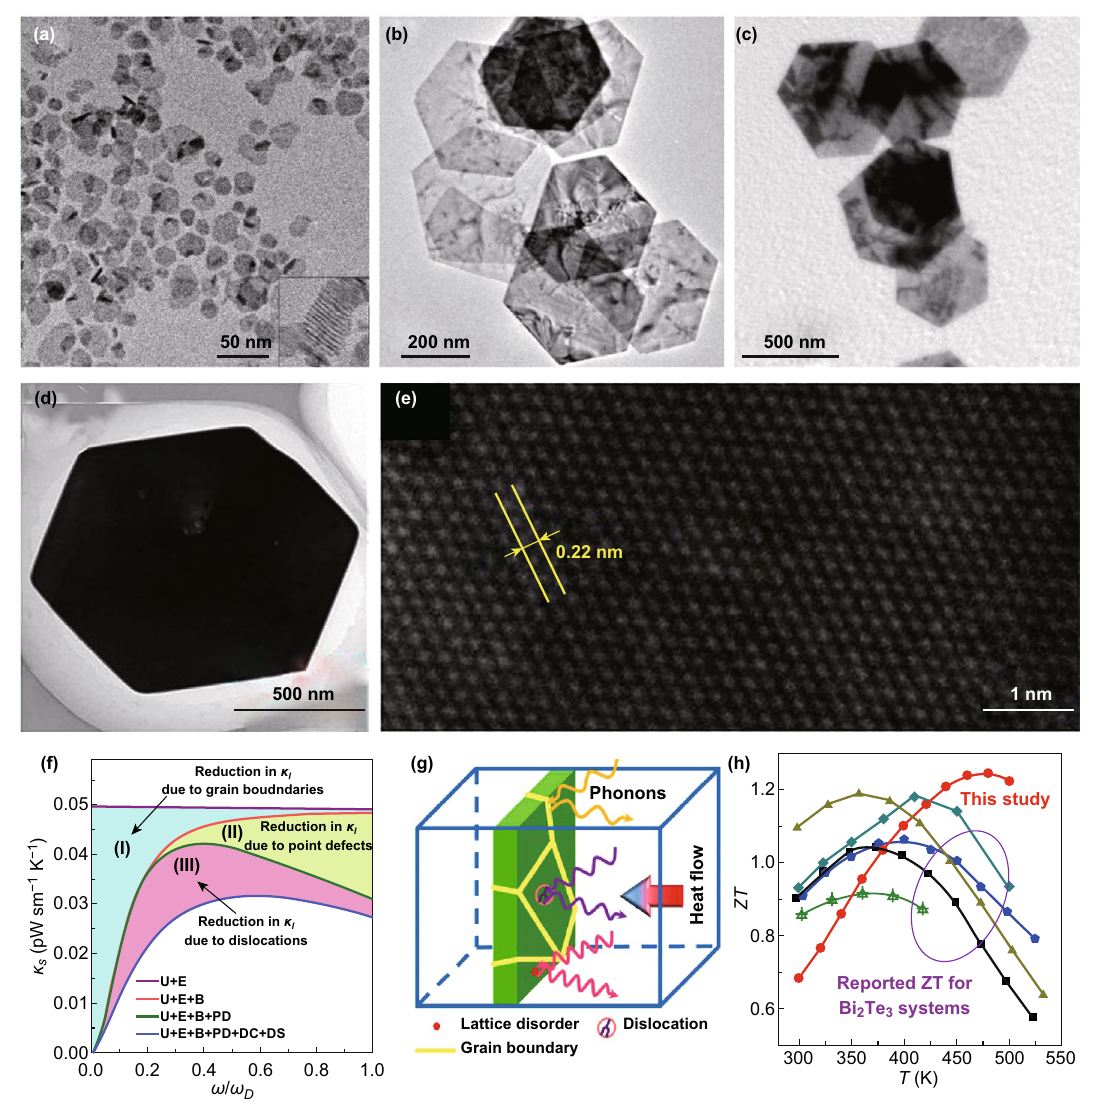
Fig. 5 a TEM image of the Bi 2 Te 3 nanoplate, the inset shows the lateral view of the stacked plates). Reproduced with permission from Ref. [161]. Copyright 2012, American Chemical Society. b Bright-field TEM image of the Bi 2 Se 3 @Bi 2 Te 3 @Bi 2 Se 3 double shell nanoplates. c TEM image of the Bi 2 Se 3 @Bi 2 Te 3 @Bi 2 Se 3 @Bi 2 Te 3 multishell nanoplates. Reproduced with permission from Ref. [162]. Copyright 2015, American Chemical Society. d TEM image, and e HRTEM image of the Bi 2 Te 2.7 Se 0.3 nanoplate. f Calculated room-temperature κ s value for the phonons scattering of the Bi 2 Te 2.7 Se 0.3 pellet. g Schematic diagram illustrating the scattering of wide-frequency phonons by various sources. h Carriers mobility and ZT value of the Bi 2 Te 2.7 Se 0.3 pellet. Reproduced with permission from Ref. [163]. Copyright 2016, American Chemical